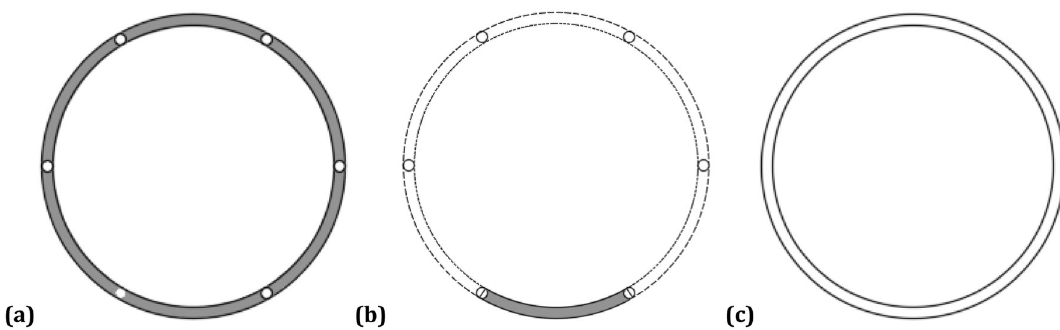
Fig. 13 Different types of tunnel ring representations: a C 1 ; b C 2 ; c C 3